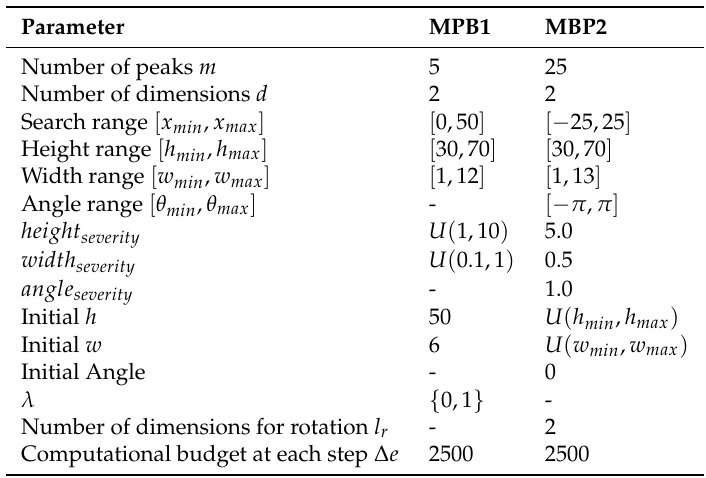
Table 3. Parameters